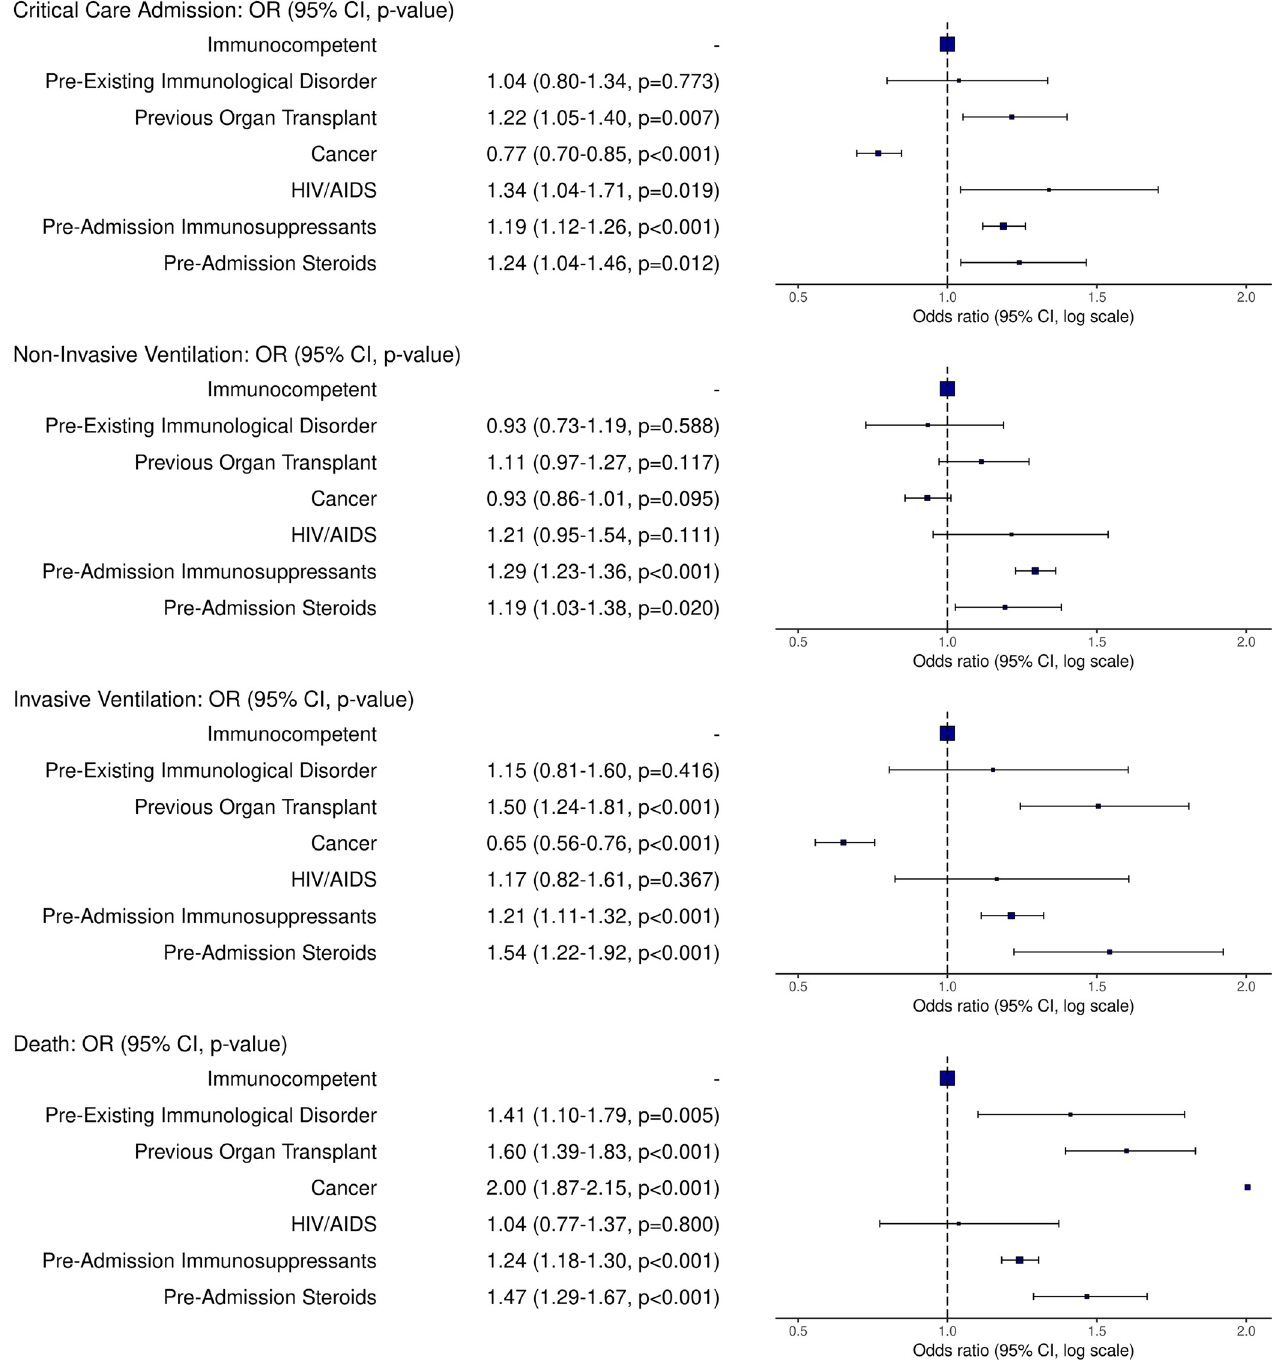
Fig 3. Outcomes of hospitalised immunocompromised patients, compared with immunocompetent patients. Odds ratios (ORs) from multivariable logistic regression and 95% confidence intervals (CIs) for outcomes of death, critical care admission, noninvasive and invasive ventilation, adjusted for age, sex, ethnicity, socioeconomic deprivation, chronic cardiac, pulmonary and renal disease, and vaccination status.